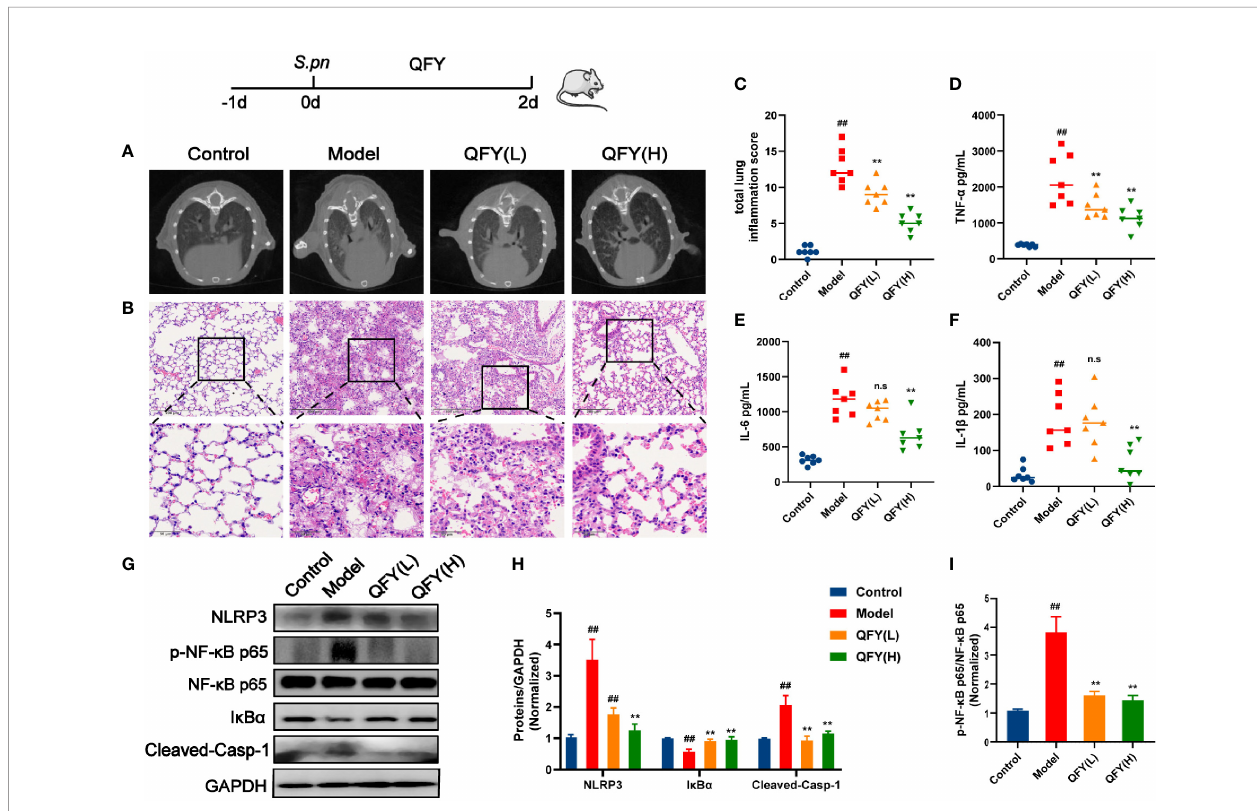
FIGURE 1 | QFY prevented S.pn -induced lung in fl ammatory injury in infected mice. Model, QFY (L), and QFY (H) groups of mice were inoculated with 2.5 × 10 8 CFU/mL S.pn in 25 m L for 48 h. (A) Micro-CT images are presented. (B) Pathologic and histopathological changes in lung tissues as revealed by H&E staining (original magni fi cation 40×, scale bar: 20 m m). (C) Total lung in fl ammation score. (D – F) Detected levels of in fl ammatory cytokines IL-1 b , IL-6, and TNF- a . (G) Western blot showing detected proteins. (H, I) Levels of quanti fi ed proteins on Western blots. Data are presented as the mean ± SD for each group. ## p < 0.01 versus Control; ** p < 0.01 versus Model; n.s, no signi fi cant